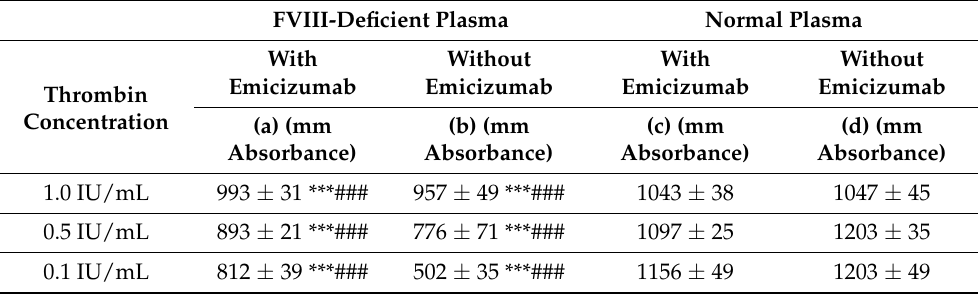
Table 1. The heights of the fibrin formation curve in the clot wave analysis of thrombin time. FVIII-Deficient